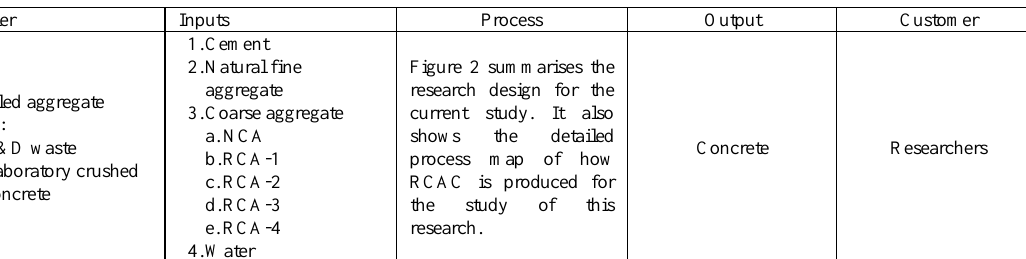
Table 1. SIPOC for the study